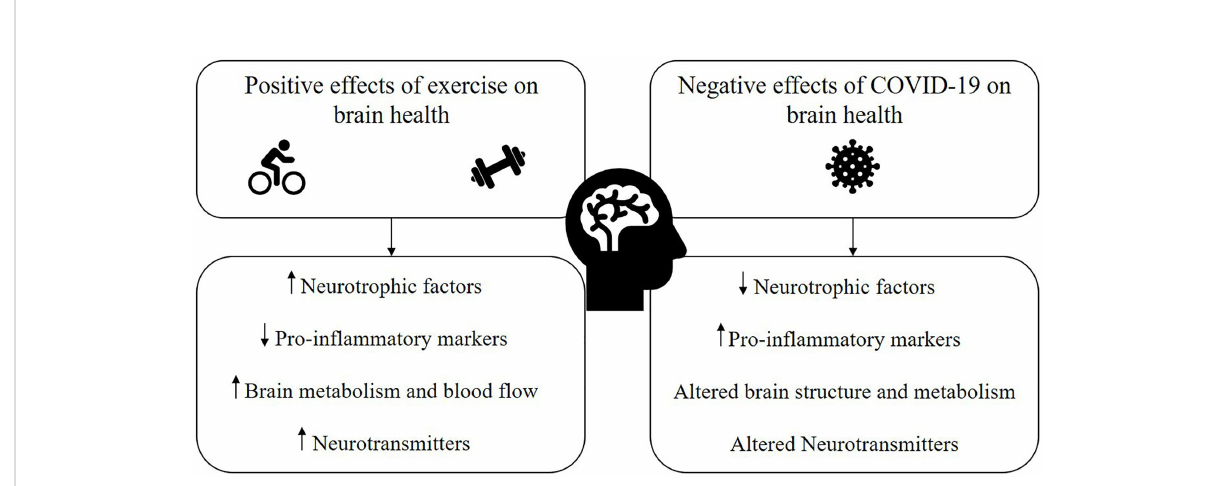
FIGURE 1 Proposed mechanisms through which exercise has the potential to mitigate the negative impact of COVID-19 and/or long COVID syndrome (LCS) on brain